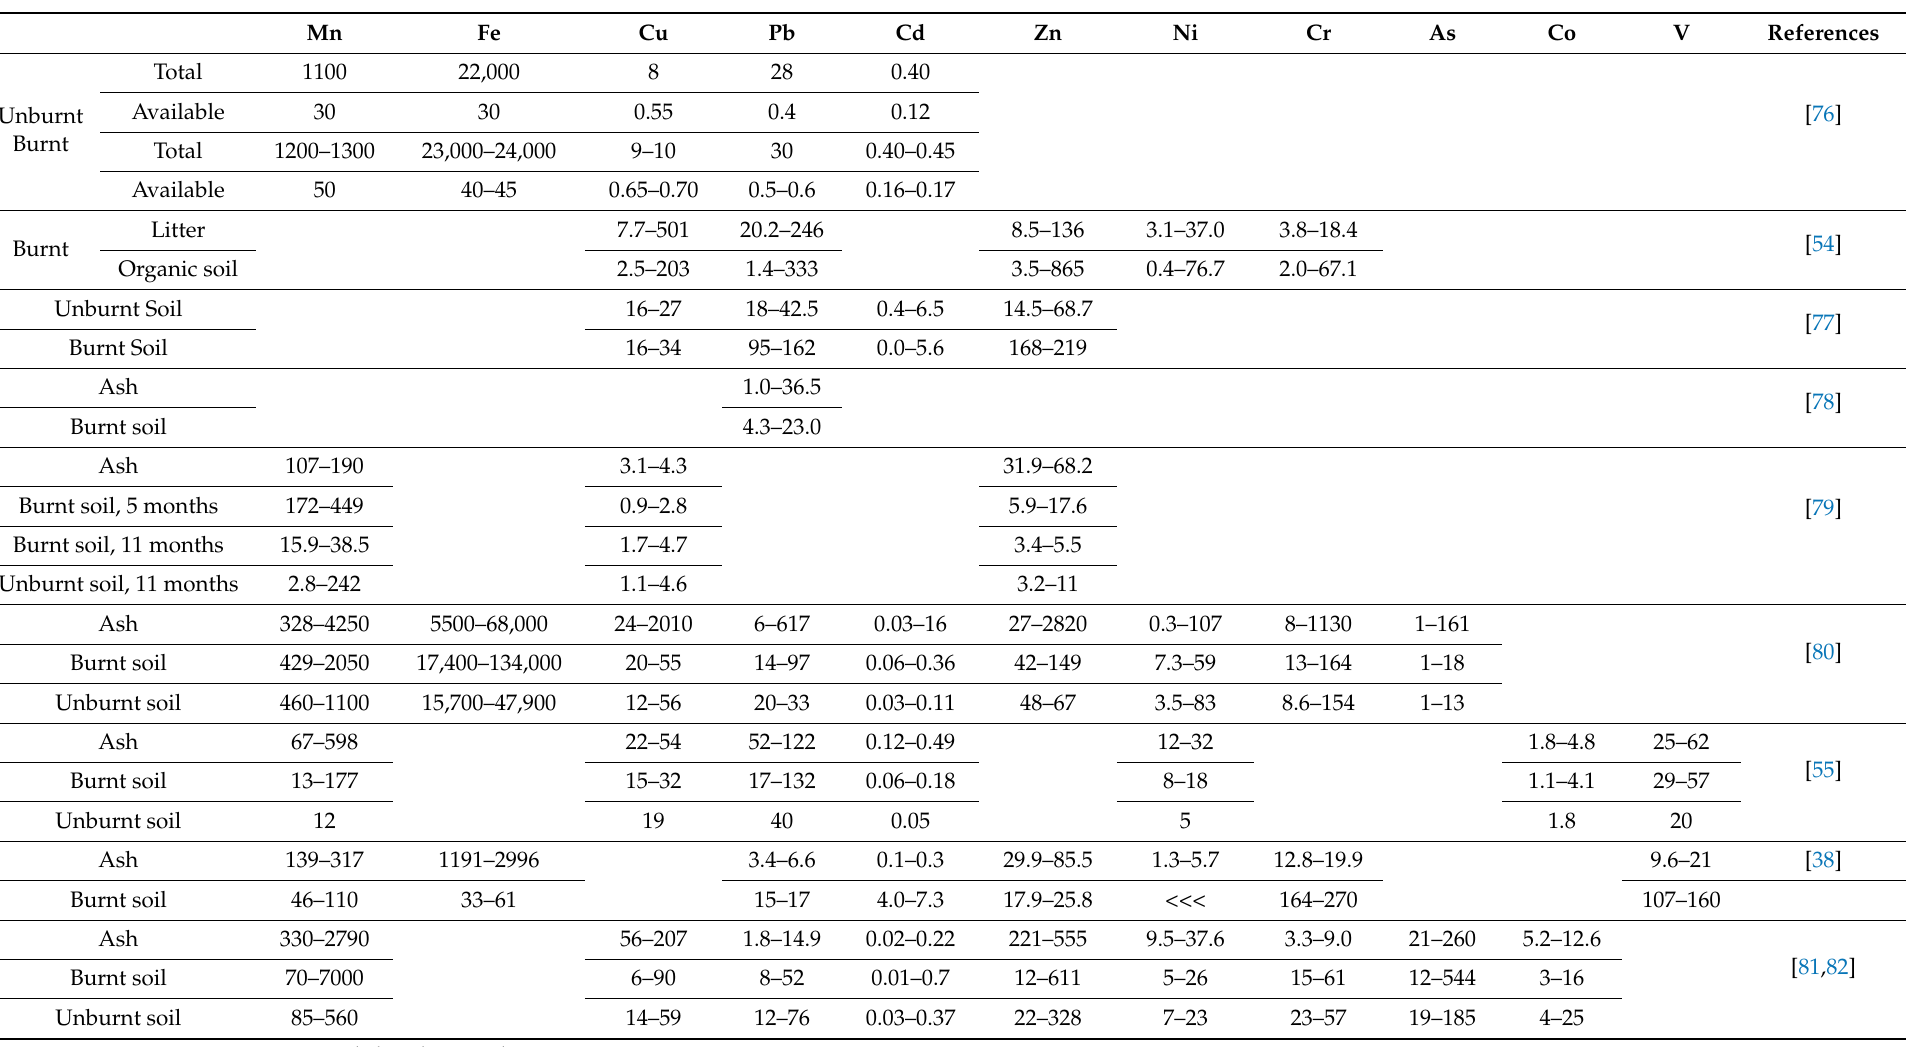
Table 6. Concentrations of various trace elements in some burnt and unburnt soils, litter, and ash (mg kg − 1